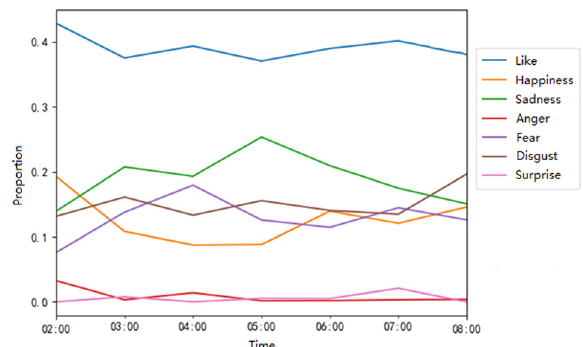
Fig. 3 Emotional distribution of Weibo posts related to ‘ Lockdown ’ . The emotional distribution of Weibo posts related to ‘ Lockdown ’ during hours after the release of the lockdown policy on January 23, 2020.